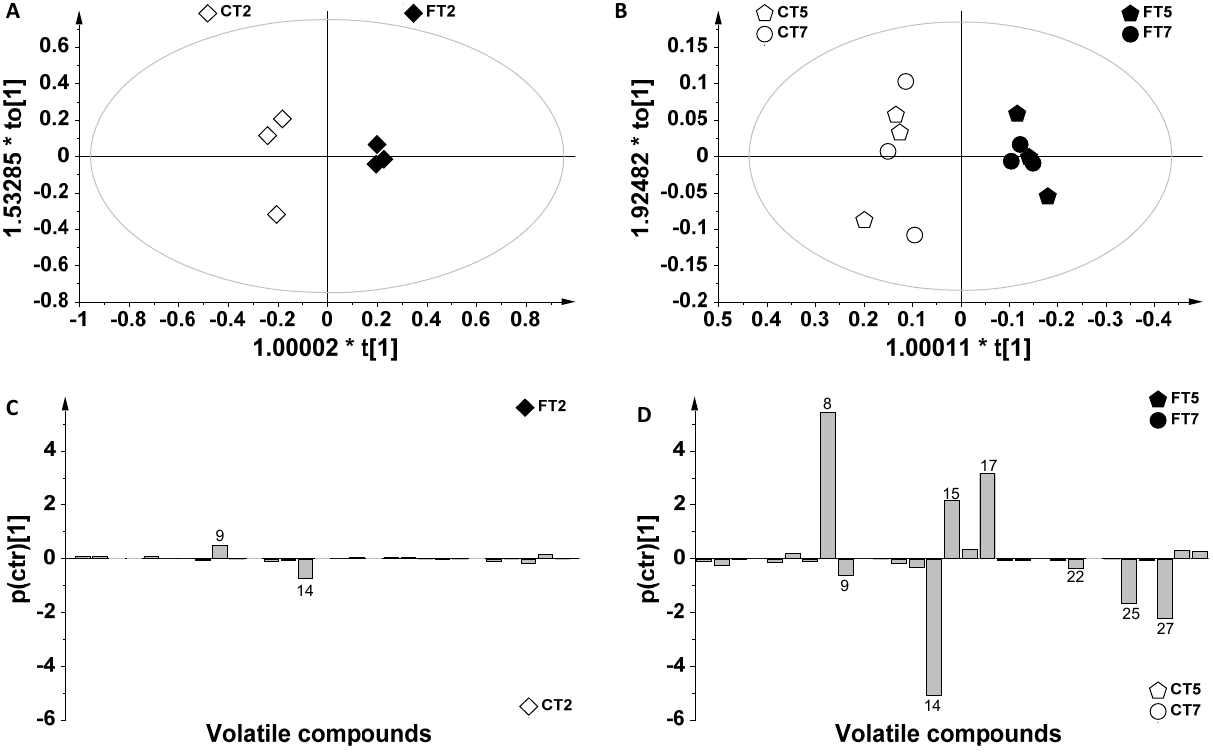
Figure 4. ( A ) Orthogonal partial least squares discriminant analysis (OPLS-DA) score plot of CT2 and FT2 samples (t[1] vs. to[1]); ( B ) OPLS-DA score of CT5/CT7 and FT5/FT7 samples (t[1] vs. to[1]); ( C ) plots of FT2 and CT2 samples showing the contribution of metabolites responsible for differences between infected samples and controls; ( D ) plots of CT5/CT7 and FT5/FT7 showing the contribution of metabolites responsible for differences between infected samples and